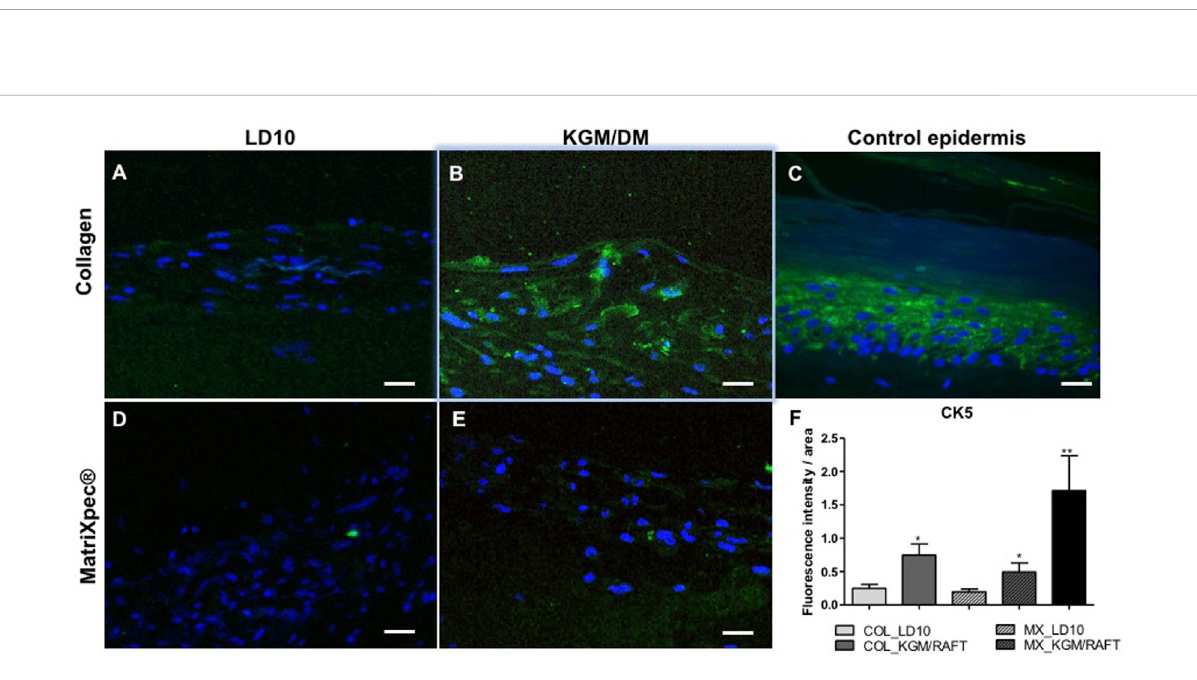
FIGURE 5 Expression of CK5byimmuno fl uorescence. (A,D) MSC cultured with LD10or (B,E) KGM/DM onto (A,B) collagenor (D,E) MatriXpec ™ . (C) Skinformedby keratinocytes (control). CK5 labeling is shown in green. Nuclei are stained in blue (DAPI Magni fi cation of 200x. Scale bar: 100 µm. (F) Mean fl uorescence intensity per pixel in each group was compared to organotypic cultures formed by MSC cultivated onto collagen support with LD10 (COL_LD10). * ( p < .05) and ** ( p <